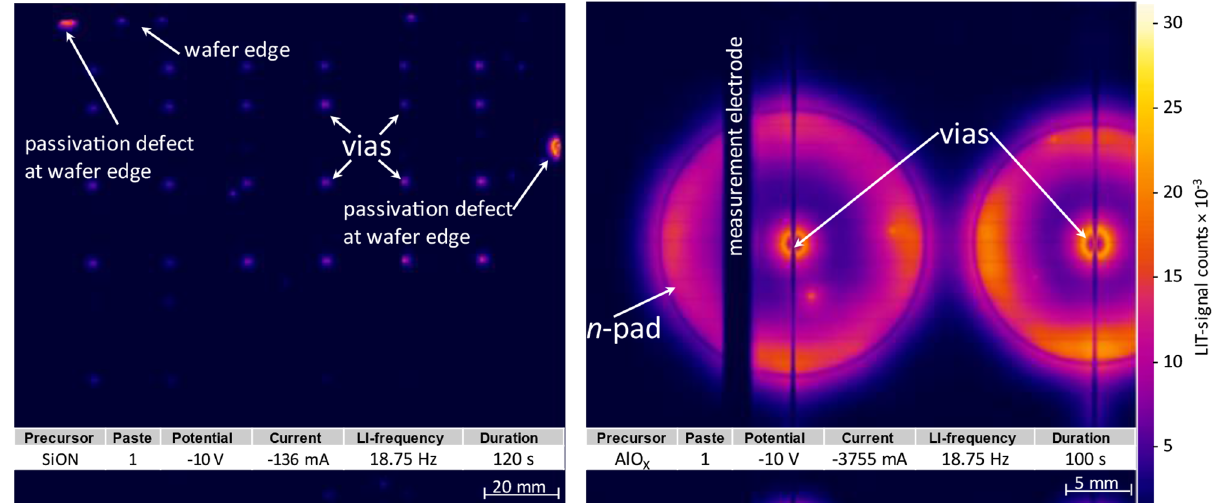
Fig. 5. LIT images full sample with SiON passivation stack (left) and zoom on Schottky and MIS contact (AlO X ) (right). The test sample with the SiON passivation stack (left) shows a signi fi cantly lower reverse current and heat emission restricted to the 24 vias and the passivation defect at the wafer edge. The MIS contact (AlO X ) of the largest n -pads ( f = 20mm) of the test structures (right) illustrating the increased current fl ow at the pad edges. Also indicated in the table below the pictures is the signi fi cantly higher current for the whole sample.